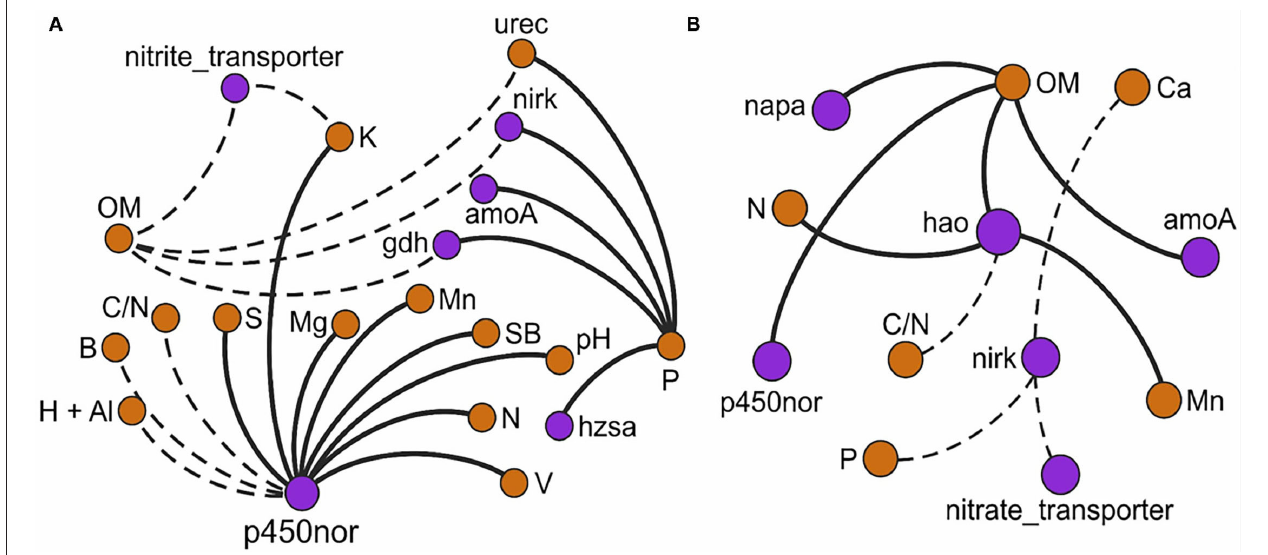
FIGURE 2 | Network correlation analysis of the GeoChip v.5.0M gene families responsive to N treatments and physicochemical soil factors based on significant ( p < 0.05) Spearman rank correlation coefficient values. (A) Sample collection 7 days after fertilizer addition; (B) Sample collection 150 days after fertilizer addition. The nodes represent the physicochemical soil factors (light brown) and gene families (purple). The thick edges represent positive correlations, and the dashed edges represent negative